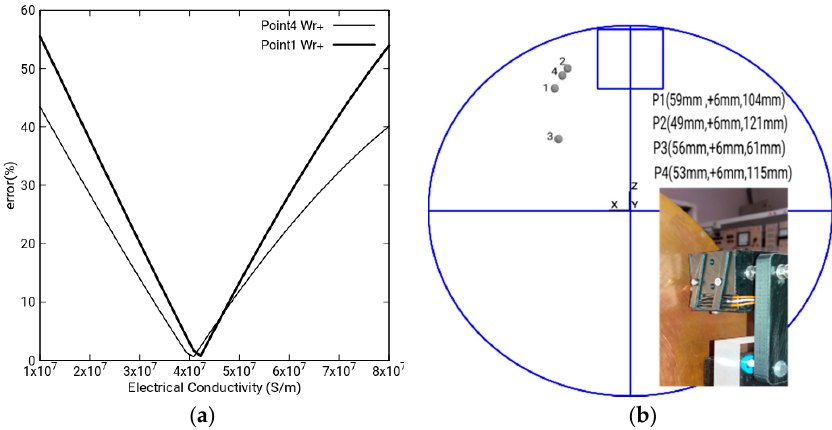
Figure 8. ( a ) Optimization of copper alloy conductivity; ( b ) position of the Hall sensors on the disk and position of the four points where the magnetic field vector has been measured.